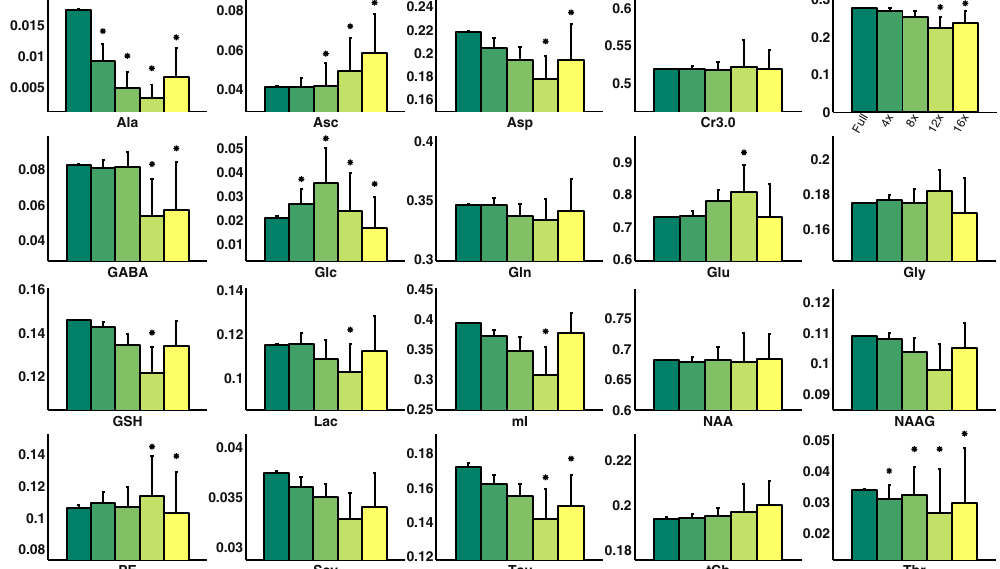
Figure 3. Bar graphs comparing the fully sampled ProFit quantitation results with the 4x, 8x, 12x, and 16x accelerated quantitation results are shown for the vphantom. An asterisk ( * ) is indicative of normalized root mean square error that exceeded 15% when compared to the fully sampled phantom for the 76 voxels. Most metabolites did not exceed the nRMSE threshold until 12x acceleration, with the exception of Ala, Asc, Glc, and Thr. Higher concentrated metabolites, such as NAA, Cr3.0, and tCh, did not show nRMSE% values higher than 15% even at 16x acceleration.